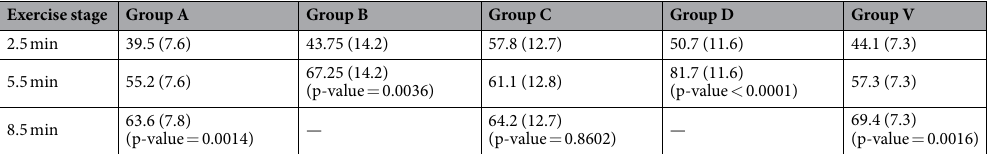
Table 3. Effect of group and exercise stage on mean † (standard error) enhanced RVM scores. † Least square means are reported. Enhancement of the relative vector magnitude (RVM) occurs in the second half of the depolarization cycle. Significant enhancement of the RVM scores occurs at a lower level of physical work in patients of Groups B and D who also had significant reduction in RVM consistent with ischaemia. Enhancement of RVM is a manifestation of change in the sequence of